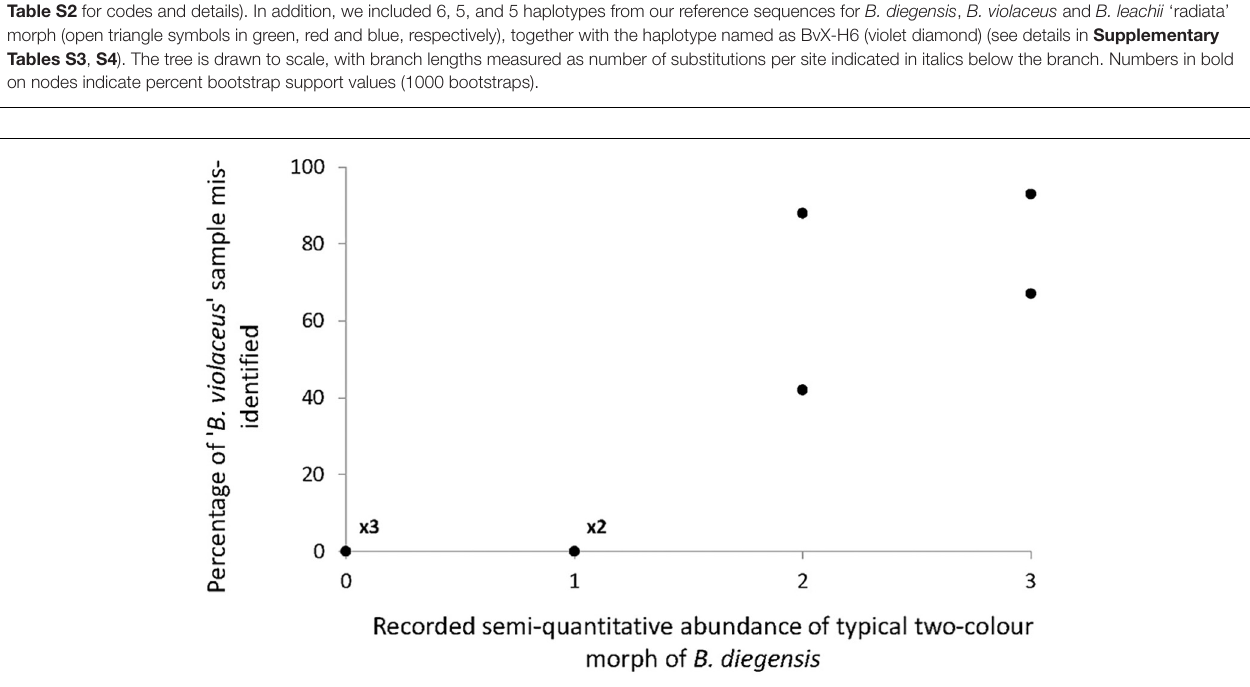
FIGURE 4 | Relationship between the percentage of B. violaceus mis-identification (i.e., individuals that were assigned to B. diegensis with barcoding) and the abundance of typical two-color morph of B. diegensis in the nine study populations on the English coast. The four-point abundance scale was obtained for B. diegensis during rapid assessment surveys carried out at the same time as sampling for molecular